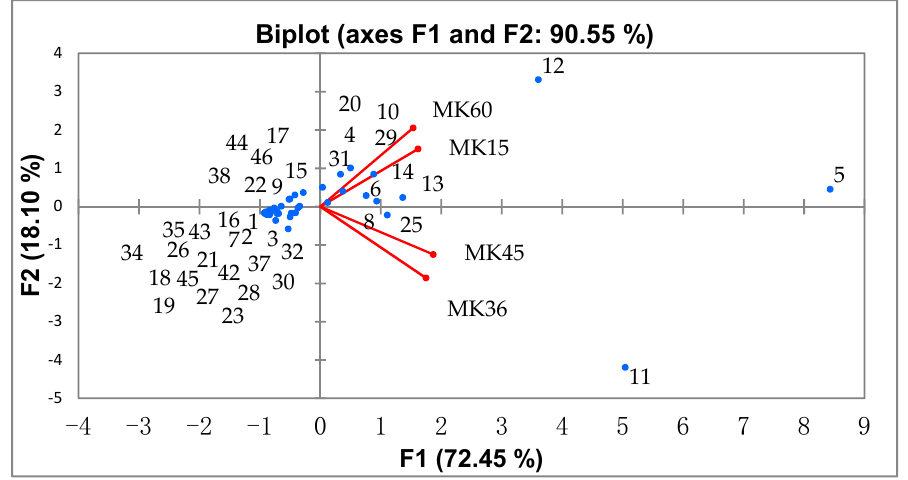
Figure 2. Principal component analysis (PCA) biplot (axes F1 and F2: 90.55%) illustrating the relationships among the chemical components and different harvesting day of makhwaen fruit essential oil.